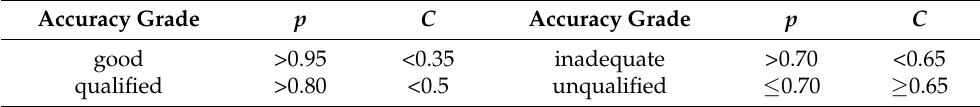
Table 3. The accuracy test grade of gray forecast model.